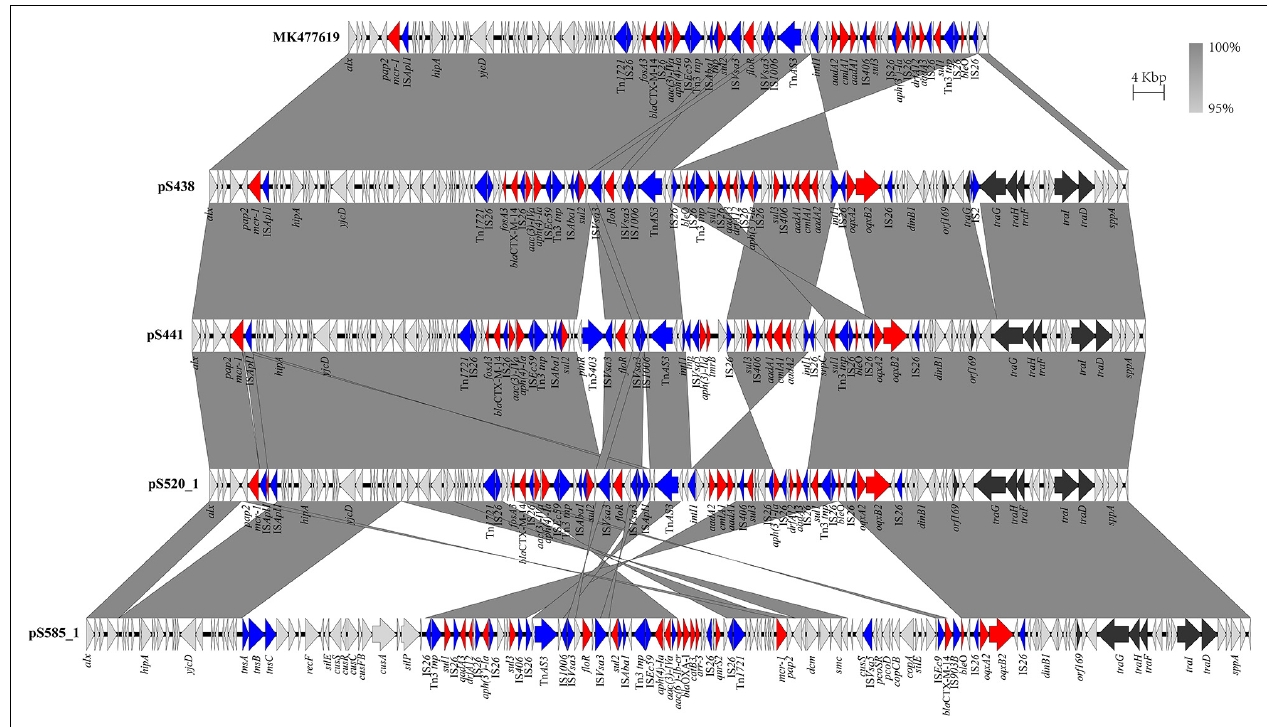
FIGURE 1 | Scaled, linear diagrams comparing the sequences of plasmid pSH16G4918 (GenBank no. MK477619), pS438, pS441, pS520, and pS585_1. Antibiotic resistance genes are indicated in red arrows. The individual conjugation-related genes are indicated with black arrows. Blue arrows denote transposon- and integron-associated genes. Other genes are shown as gray